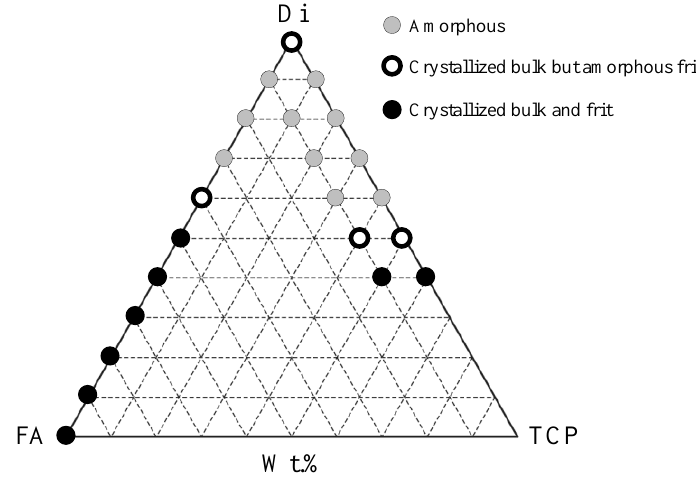
Figure 5. Graphical representation of the alkali-free bioactive glass compositions investigated [275,284,300,301,314].